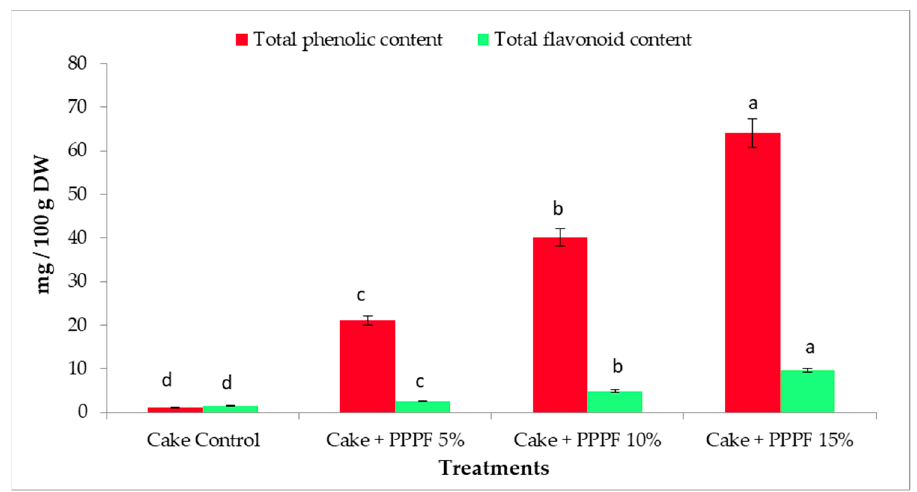
Figure 4. Total phenolic (mg GAE/100 g DW) and total flavonoids (mg QE/100 g DW) contents in cake supplemented with different levels of prickly pear peel flour (PPPF). Each value represents the mean ( ± SD) of three different replications. The different letters on the same bar show a significant difference according to Duncan’s test at p ≤ 0.05. GAE: gallic acid; QE: quercetin.